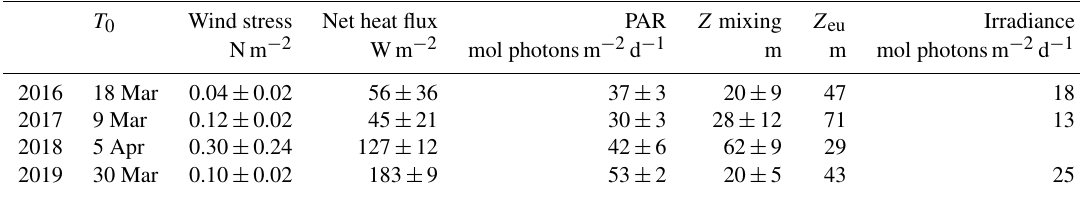
Table 2. 2016–2019. Atmospheric drivers of the onset of the bloom: average values and standard deviation on the day of the start of the bloom, T 0 . T